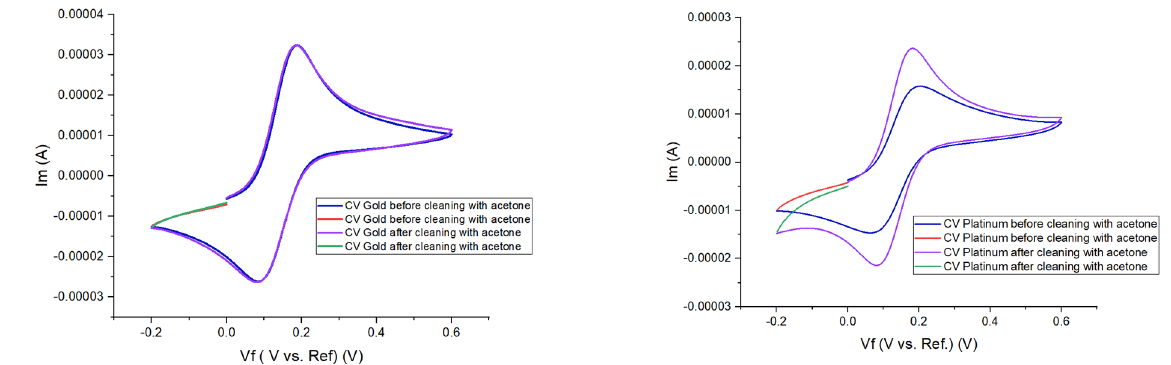
Figure 3. CV screen-printed electrodes with a gold and platinum working electrode before and after cleaning with acetone: blue/red-CV before cleaning; purple/green-CV after cleaning. Created with OriginPro. Table 1. Electrochemical measurements before and after exposure to acetone.